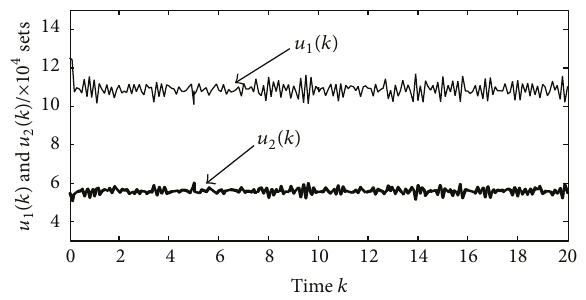
Figure 6: Evolution processes of production and ordering quantity under the fuzzy robust 𝐻 ∞ control strategy.